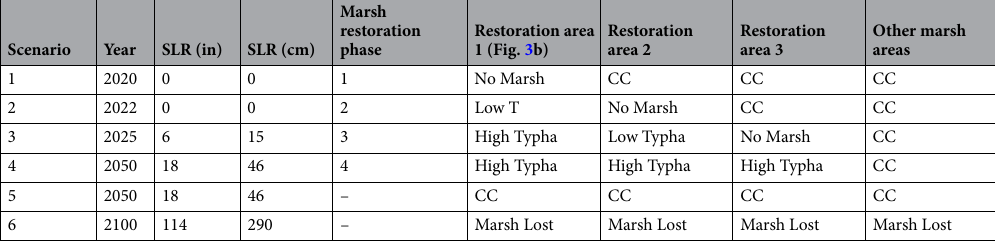
Table 1. Coastal flood scenarios from 2020 to